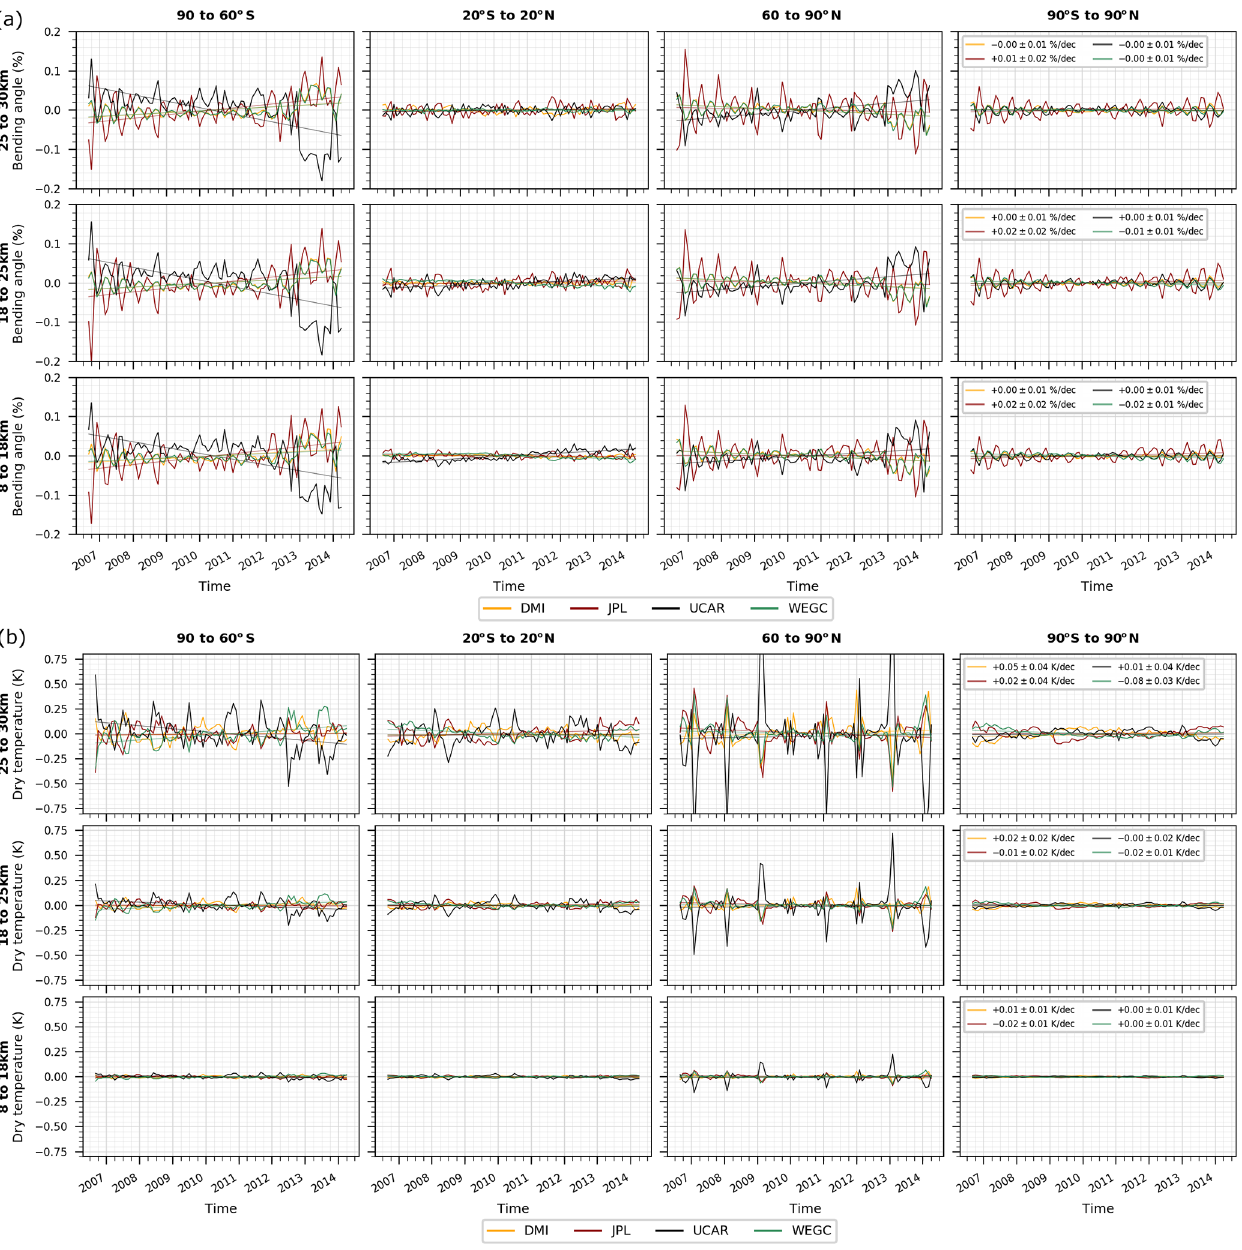
Figure 5. F3C bending angle (a) and dry temperature (b) de-seasonalized anomaly difference time series based on 10 ◦ zonal medians of each center to the all-center mean for latitude bands 90 to 60 ◦ S, 20 ◦ S to 20 ◦ N, 60 to 90 ◦ N, and globally 90 ◦ S to 90 ◦ N (left to right) for altitude layers 8–18, 18–25, and 25–30km (bottom to top). Time series from DMI (orange), JPL (red), UCAR (black), and WEGC (green) are